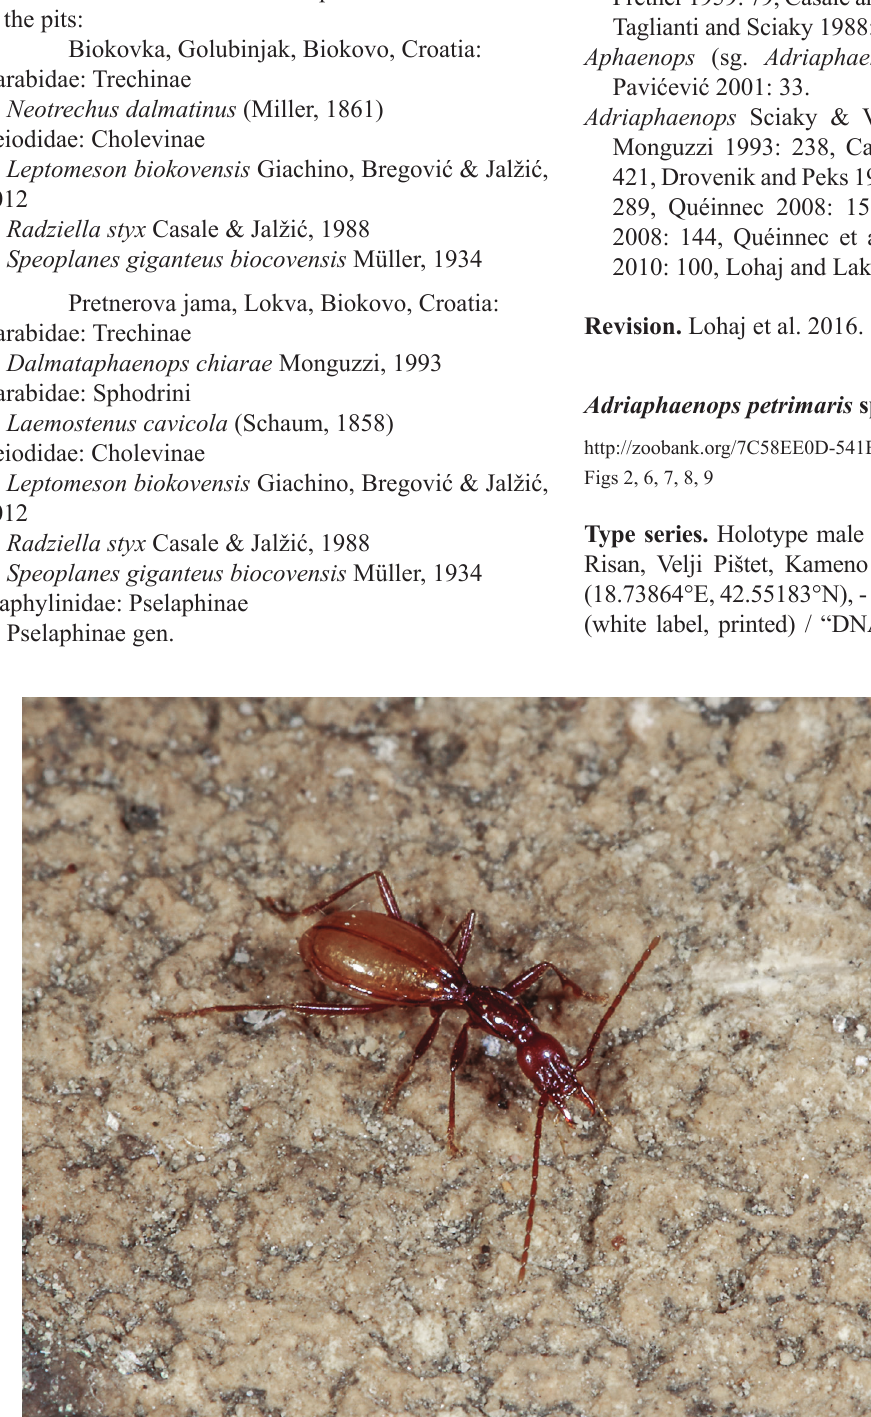
Figure 6. Adriaphaenops petrimaris sp. n. in its natural habitat in Pištet 4 cave, Velji Pištet, Kameno more,